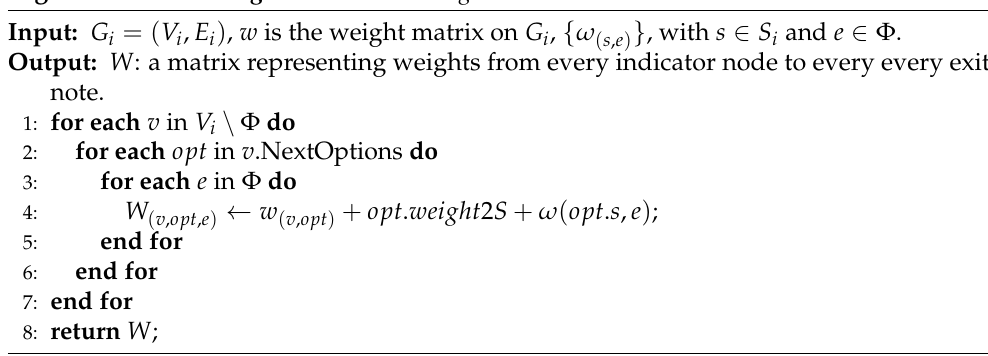
Algorithm 4 TotalWeightEval —Total Weight Evaluation